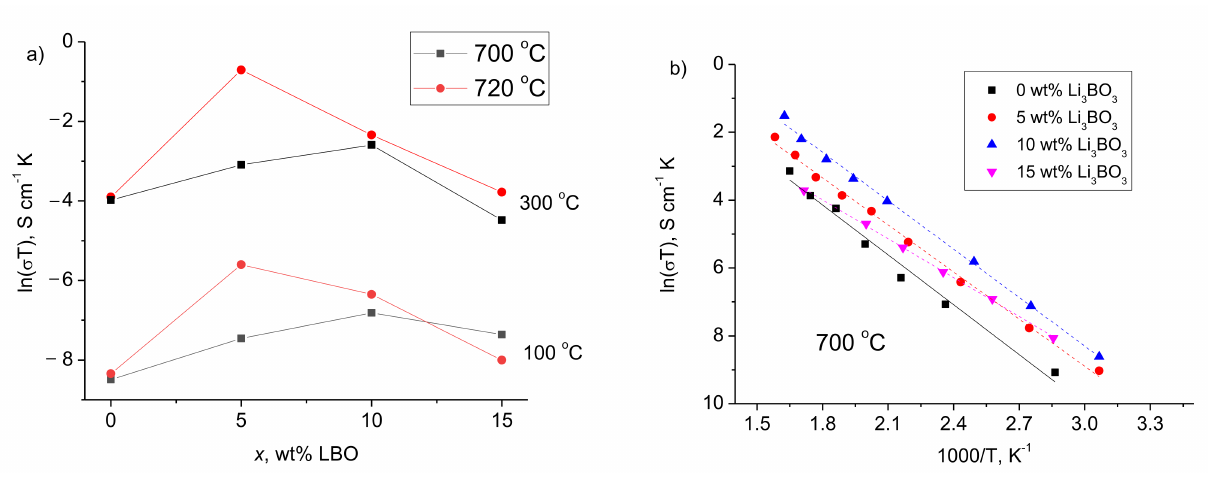
Figure 5. Concentration dependences ( a ) and Arrhenius plots ( b ) for the total conductivity of (100 − x )LiCoO 2 + x Li 3 BO 3 |c- LLZ half-cells.